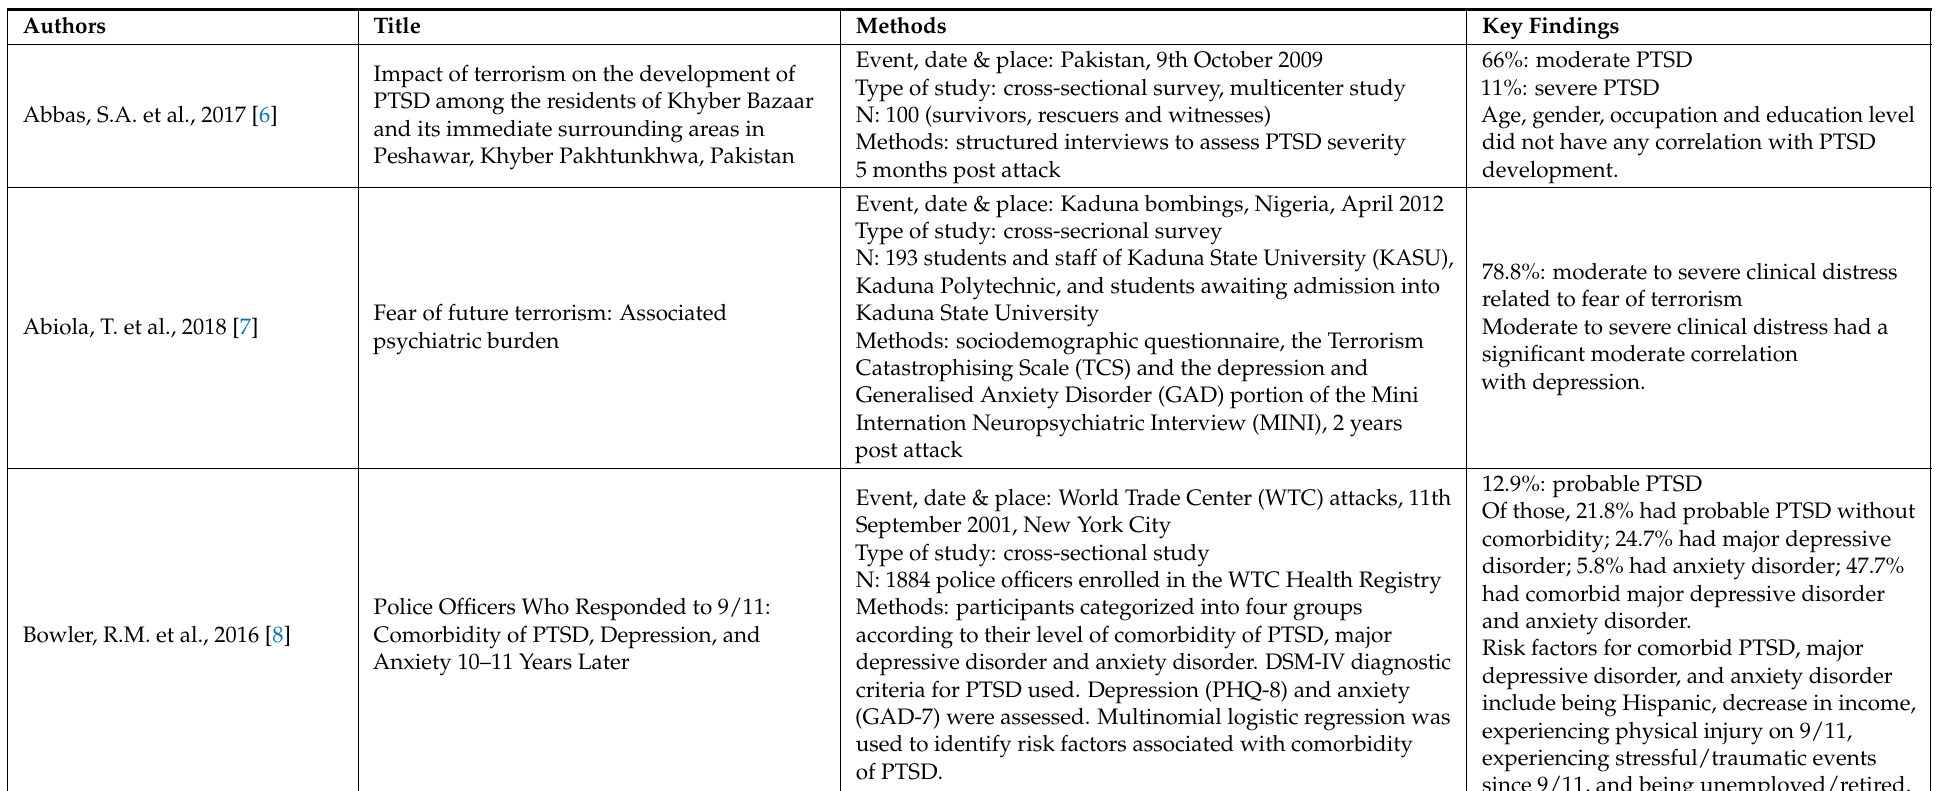
Table 1. Prevalence of mental disorders after terrorist